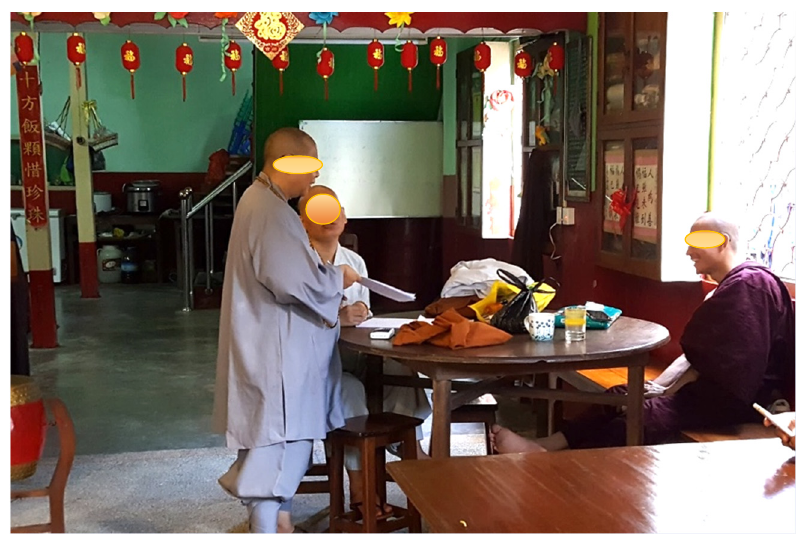
Figure 1. The abbess of Zhonghua Si having a friendly chat with a Burmese monk (Source: Author).